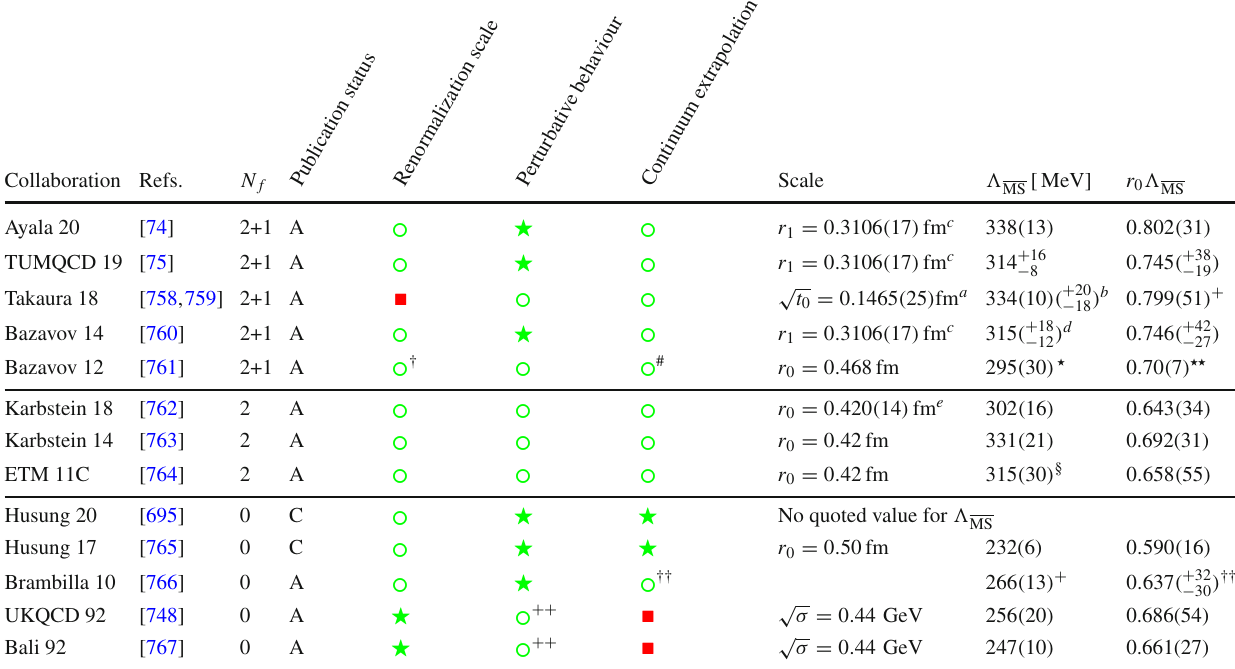
Table 61 Short-distance potential